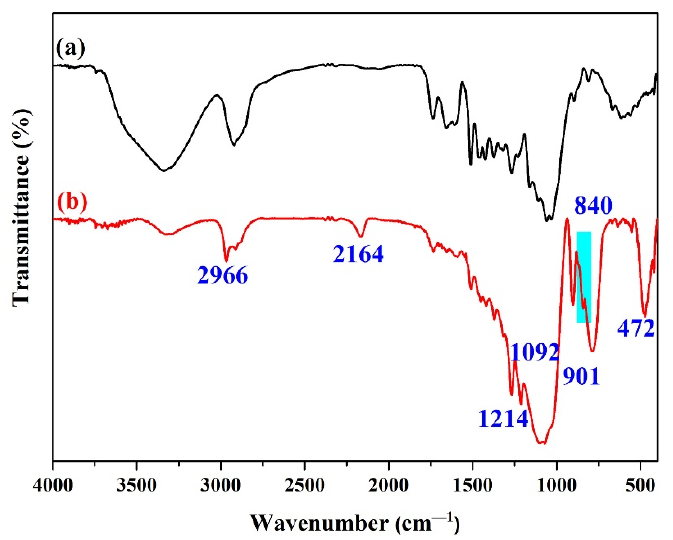
Figure 3. FTIR spectra of original wood ( a ) and HFSO/V 4 2:1 modified wood sample ( b ).